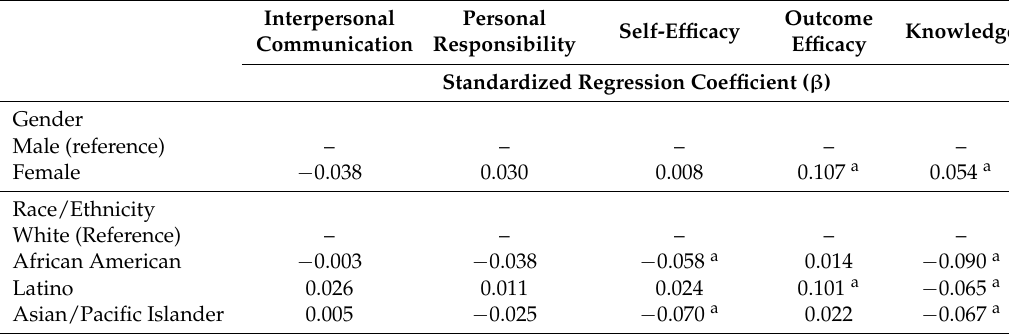
Table 4. Linear regression of demographics and ShakeOut participation clusters on social cognitive factors ( N =